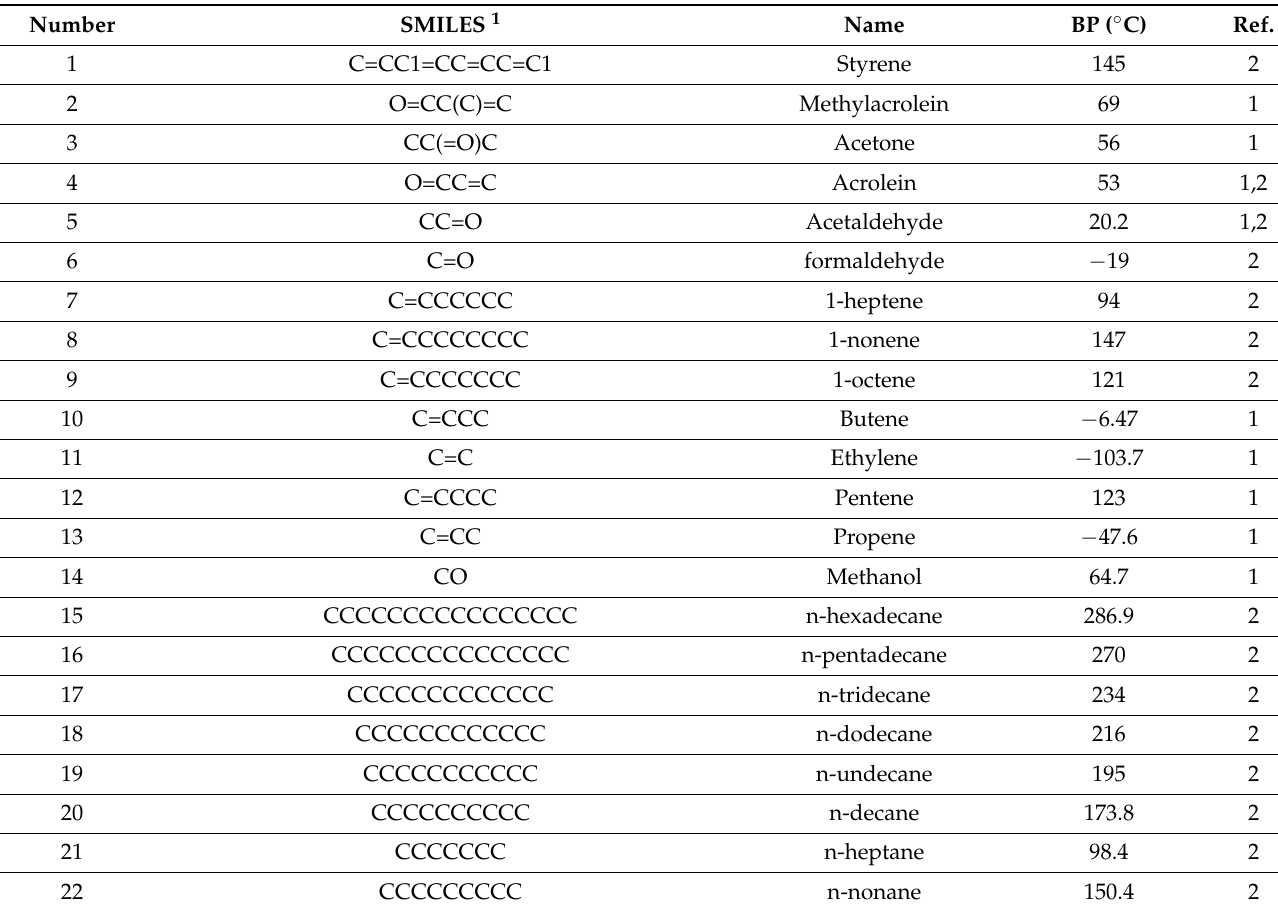
Figure 1. Summary of data from the monthly average values from the IGRS database, for measure- ments between 0 ◦ and 70 ◦ degrees latitude. Left –average temperature at each of the four pressure standards reported, graphed per month. Centre –distribution of the monthly average temperatures across the whole dataset of 1,629,727 monthly average measurements, by altitude band. Right – average water vapour pressure, as a function of atmospheric measurement pressure. Table 1. Incomplete combustion products of commercial jet